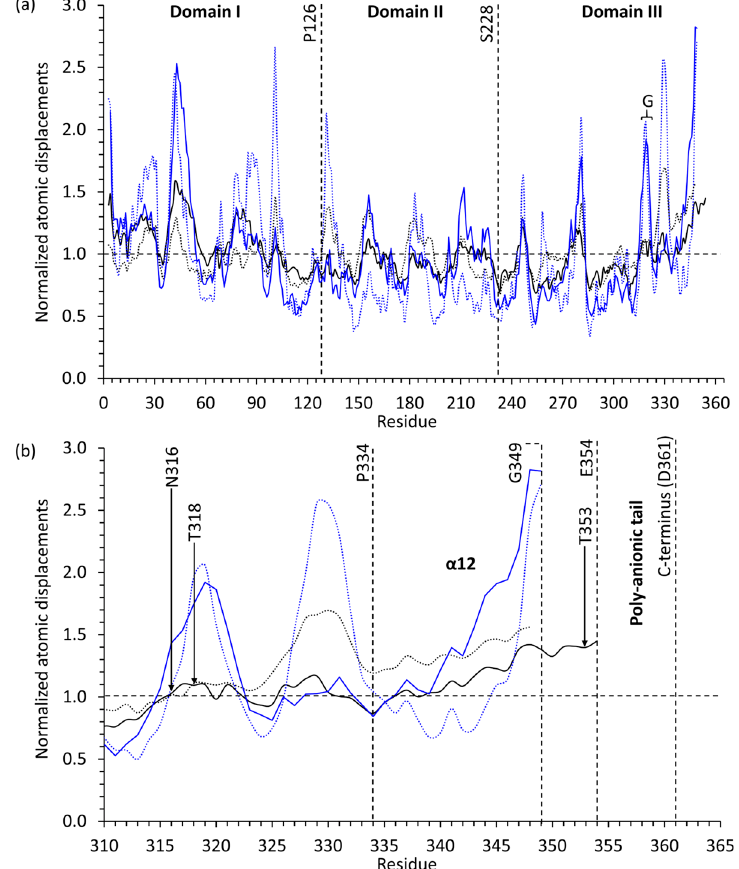
Figure 11. A plot of protein backbone atomic displacement parameters of the low-Ca 2+ (black dashed lines for native, blue dashed lines for recombinant) and high-Ca 2+ (black solid lines for native, and blue solid lines for recombinant) structures of native and recombinant bovine Casq1, normalized to their respective mean backbone atomic displacements and averaged for the asymmetric unit. ( a ) Dashed lines demarcate Domains I, II and III, and residue labels show the terminus of each domain. The letter G marks the location of the glycosylation loop; ( b ) close up of the 51 terminal residues. N316 is the N-linked glycosylation site; T318 is the terminal residue of the N-linked glycosylation sequence; and Thr353 is the residue seen to be hydrogen bonding with the first GlcNAc of high-Ca 2+ native bovine Casq1.